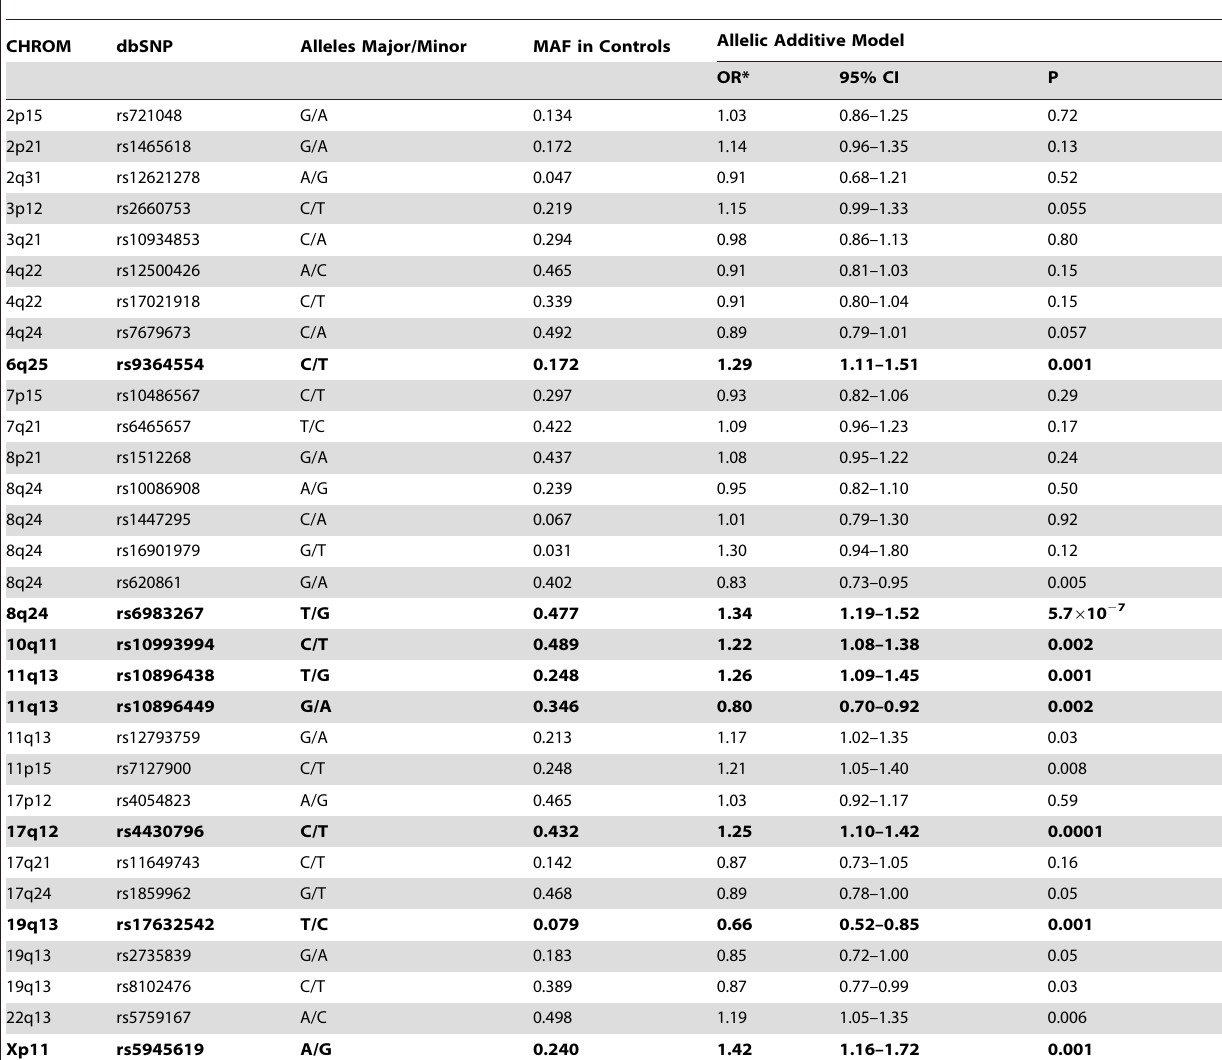
Table 1. Associations of GWAS SNPs with Overall Risk of Prostate Cancer among Ashkenazic Men.